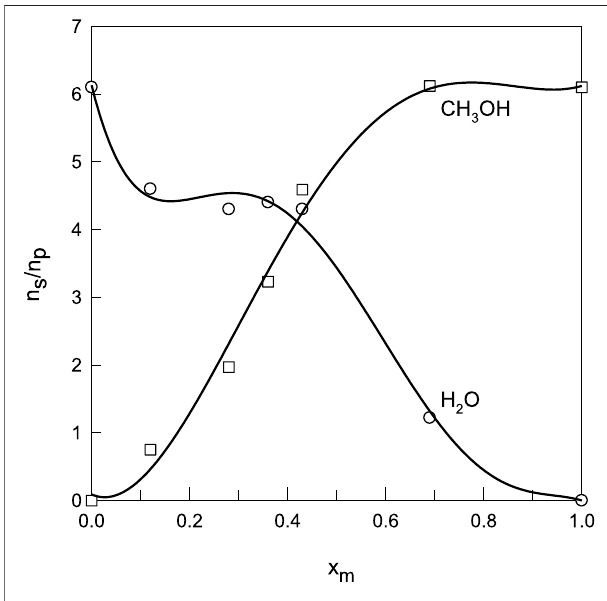
FIGURE 5 | Sorption of water and methanol in Na fi on, expressed as molesofsolventpermoleofpolymer,asafunctionofthesolventcomposition. Data from Diaz et al,